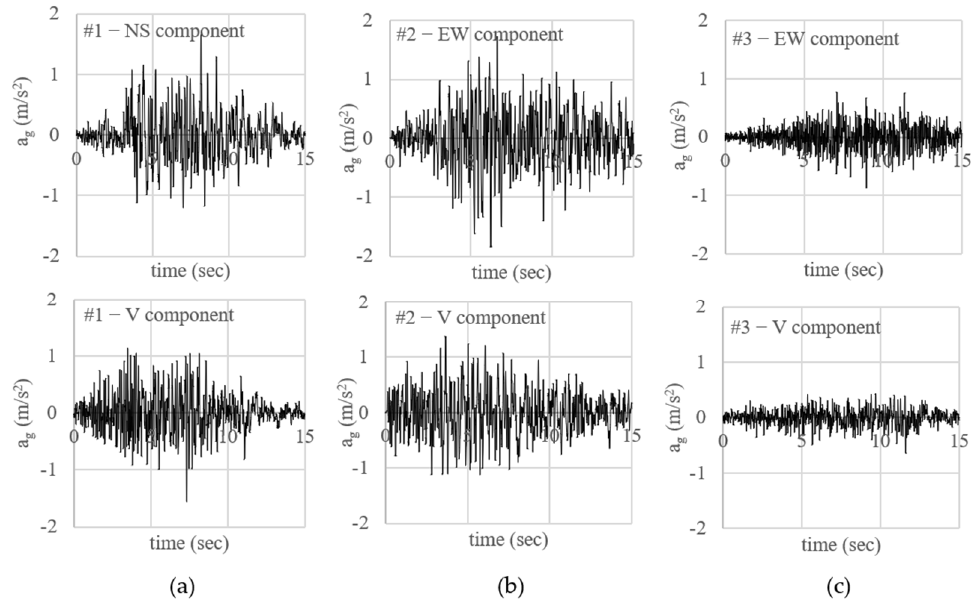
Figure 9. Horizontal (top row) and vertical (bottom row) recorded accelerograms: ( a ) earthquake #1, Norcia 30 October 2016, 14.9 km from the epicentre; ( b ) #2 Norcia 30 October 2016, 19.2 km from the epicentre; and ( c ) #3 Norcia 30 October 2016, 20 km from the epicentre. The ratios PGA V /PGA H of the records #1, #2, and #3 are equal to 0.94, 0.74, and 0.73, respectively.